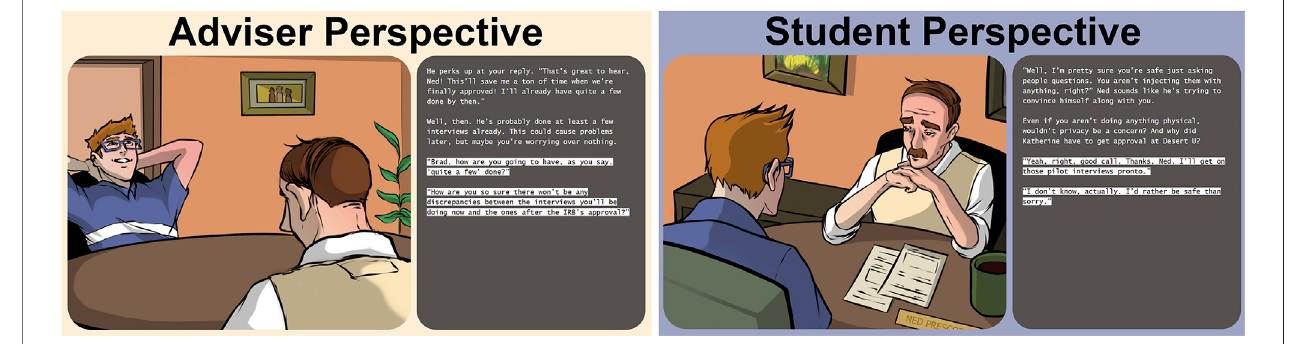
FIGURE 1 | Two perspectives and corresponding choice points from Academical ’ s fi rst scenario, “ The Head Start. ” In this story, the player can role-play as an adviser or a graduate student struggling to navigate the human subjects research approval process. The two highlighted text blocks from each scene represent the player ’ s dialogue options for their